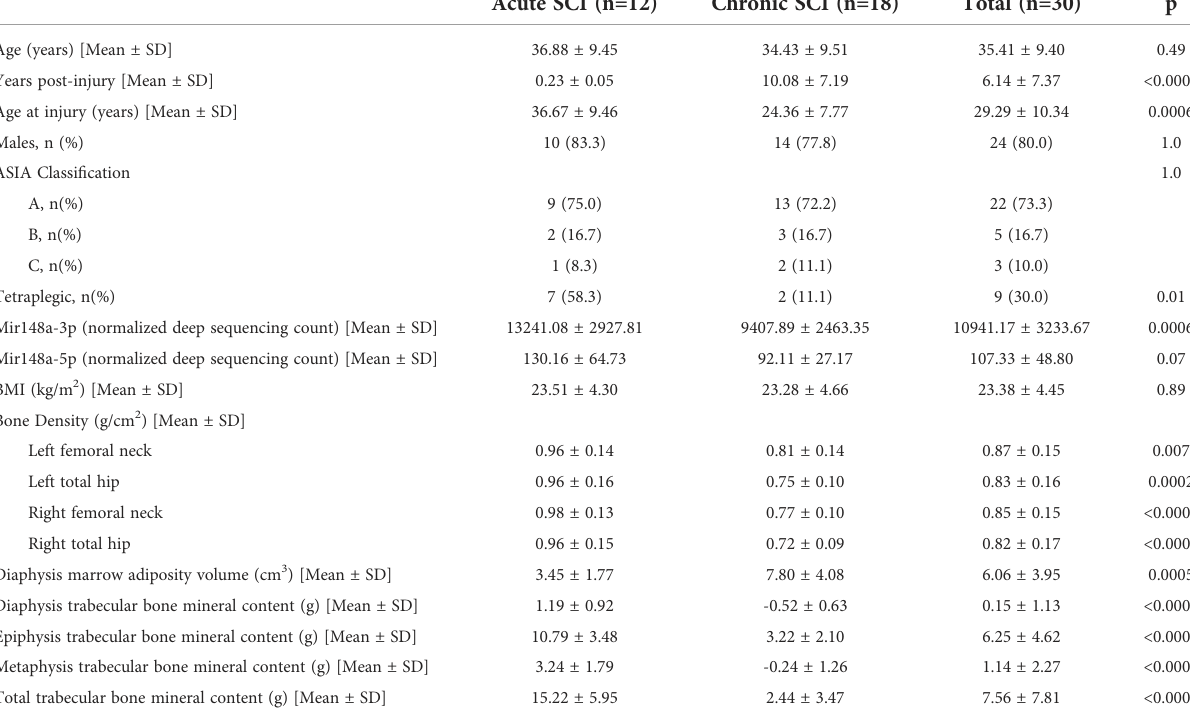
TABLE 1B Characteristics of SCI